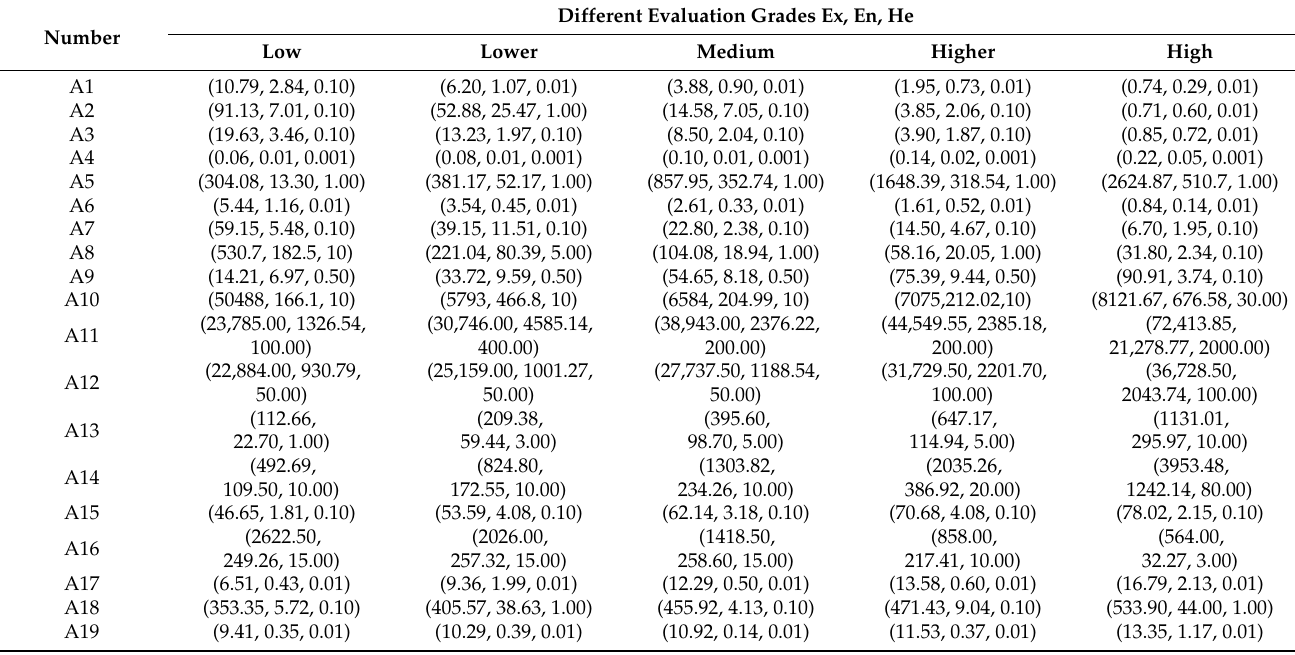
Table 3. Normal cloud membership degree of different grades of LCCC in Liaoning Province.